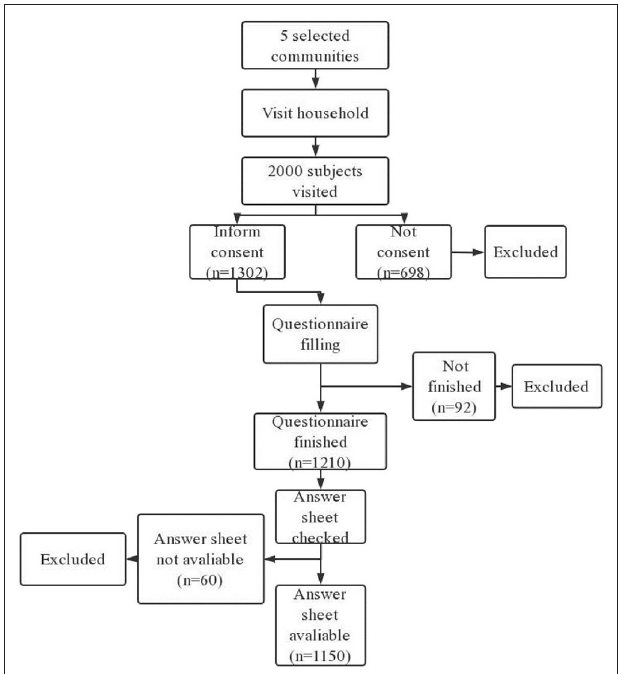
with higher scores representing more severe PTSD